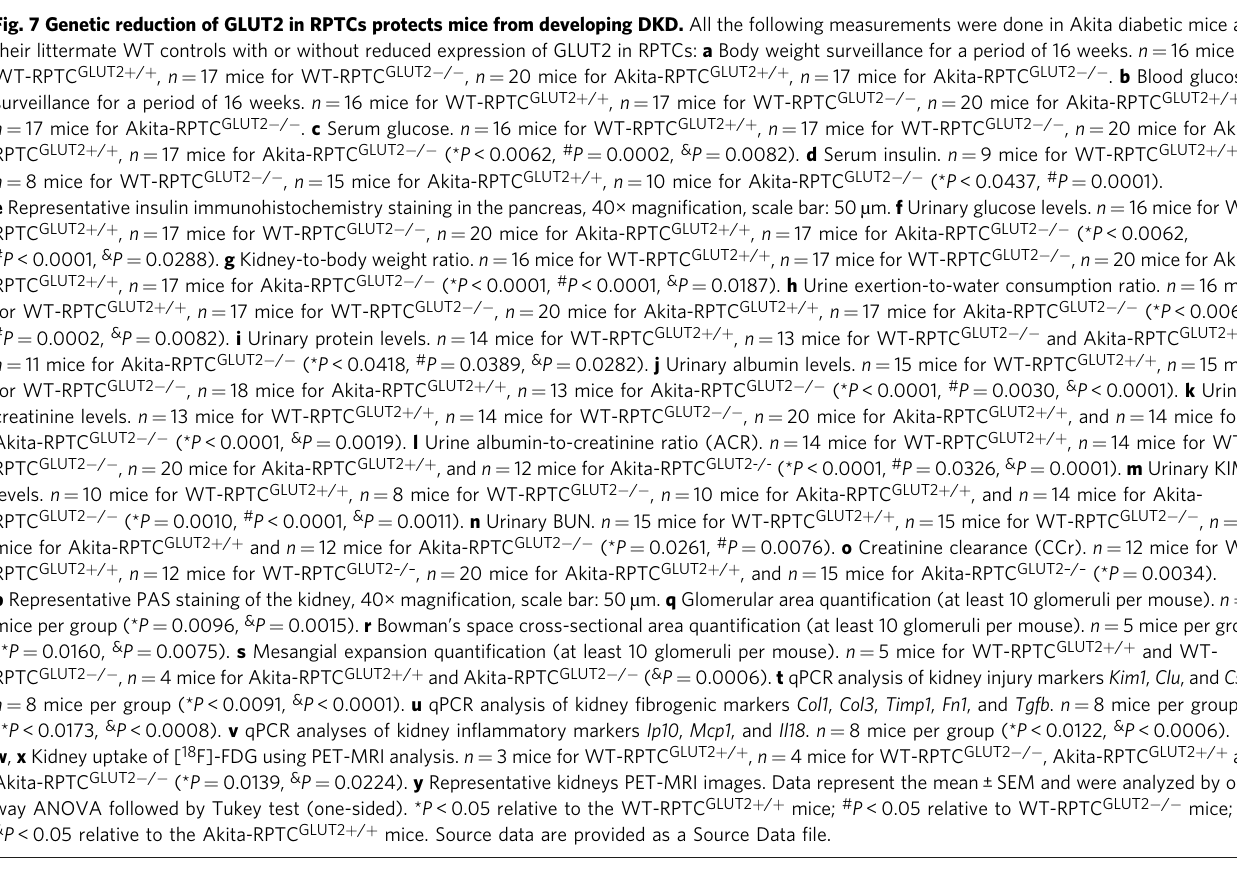
Fig. 7 Genetic reduction of GLUT2 in RPTCs protects mice from developing DKD. All the following measurements were done in Akita diabetic mice and their littermate WT controls with or without reduced expression of GLUT2 in RPTCs: a Body weight surveillance for a period of 16 weeks. n = 16 mice for WT-RPTC GLUT2 + / + , n = 17 mice for WT-RPTC GLUT2 − / − , n = 20 mice for Akita-RPTC GLUT2 + / + , n = 17 mice for Akita-RPTC GLUT2 − / − . b Blood glucose surveillance for a period of 16 weeks. n = 16 mice for WT-RPTC GLUT2 + / + , n = 17 mice for WT-RPTC GLUT2 − / − , n = 20 mice for Akita-RPTC GLUT2 + / + ,